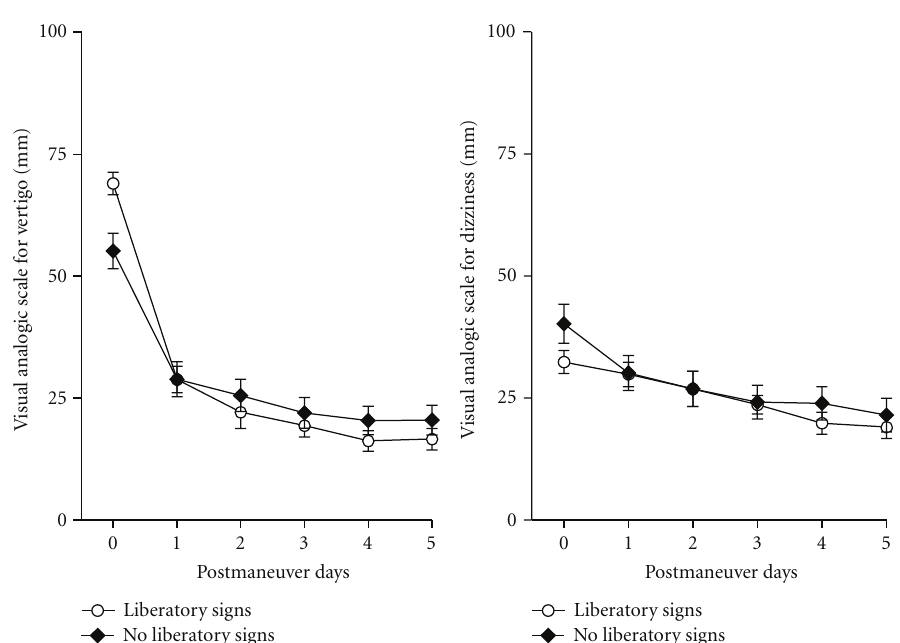
Figure 4: Time course of visual analog scale for vertigo and dizziness following liberatory nystagmus and vertigo: VAS was compared between groups with and without liberatory nystagmus and vertigo independently from the type of maneuver. Scores decreased in both groups with time and no di ff erence could be observed between the 2 groups (not significant for the e ff ect of liberatory signs and P < 0 . 0001 for the e ff ect of time, two-way,